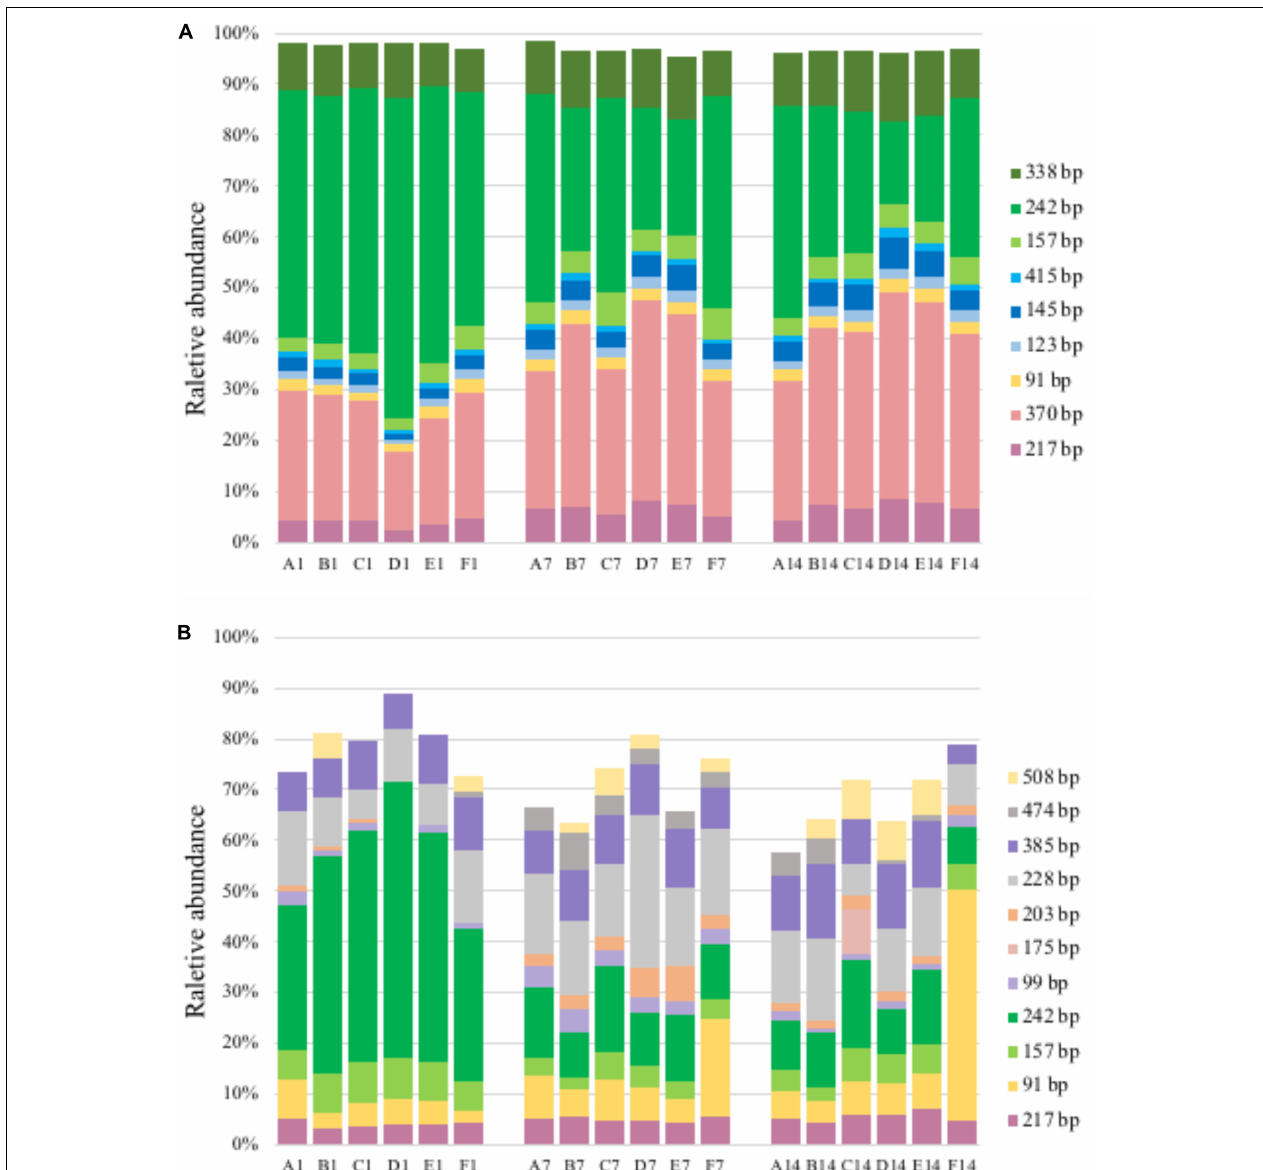
FIGURE 4 | T-RFLP profiles based on pmoA gene (A) and transcripts (B) . For sample name, upper case letters refer to treatment while digits indicate sampling